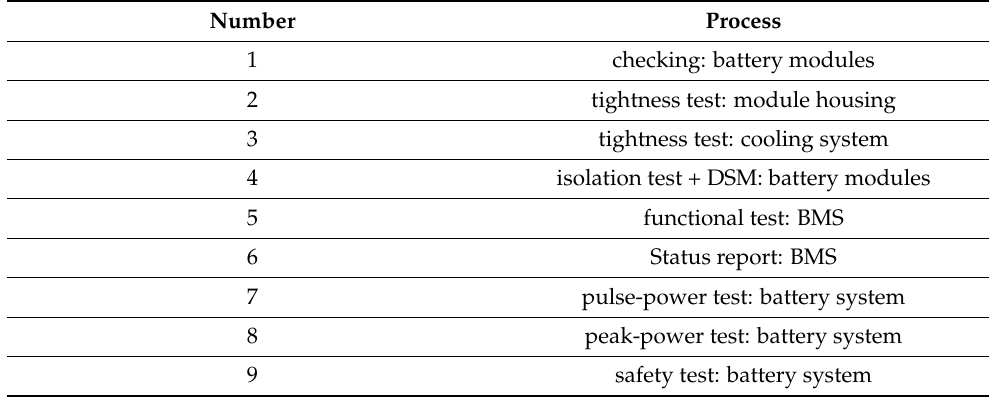
Table A13. Activities of the main application process “repurpose”: checking (EoL).